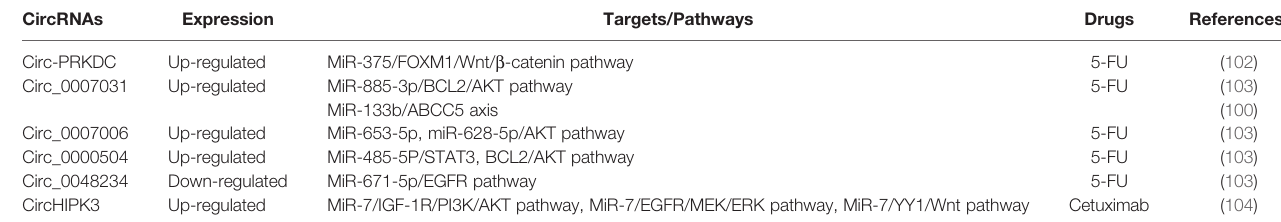
TABLE 3 | CircRNAs involved in drugs resistance in